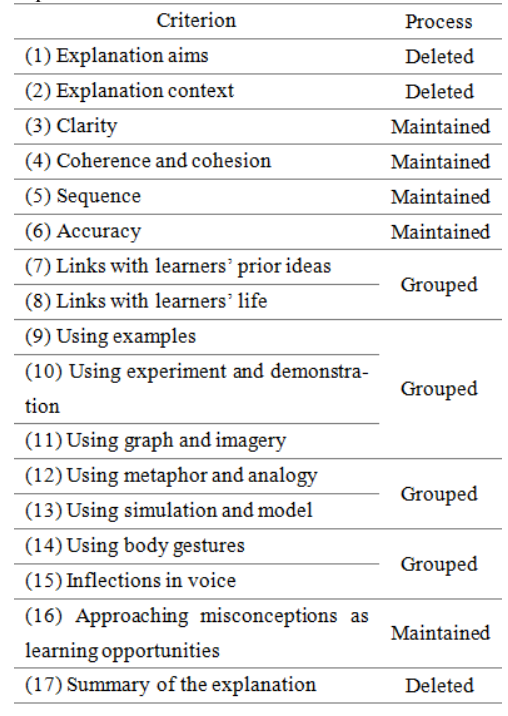
Table 1. Criteria from literature review and